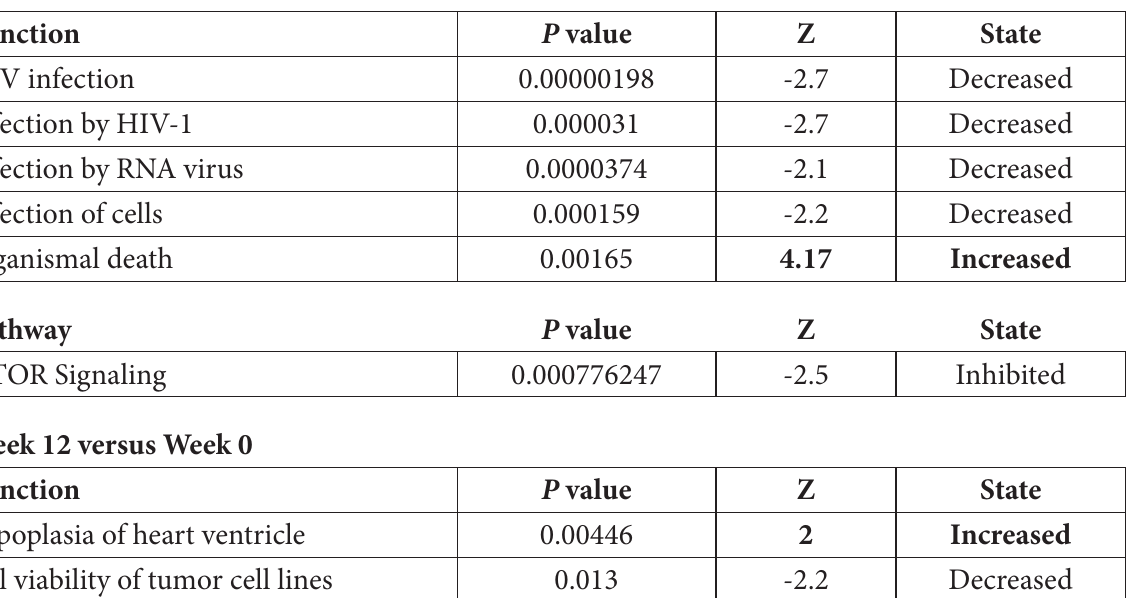
Table 5. Ingenuity Pathway Analysis functions altered at week 6 and week 12 of atorvastatin